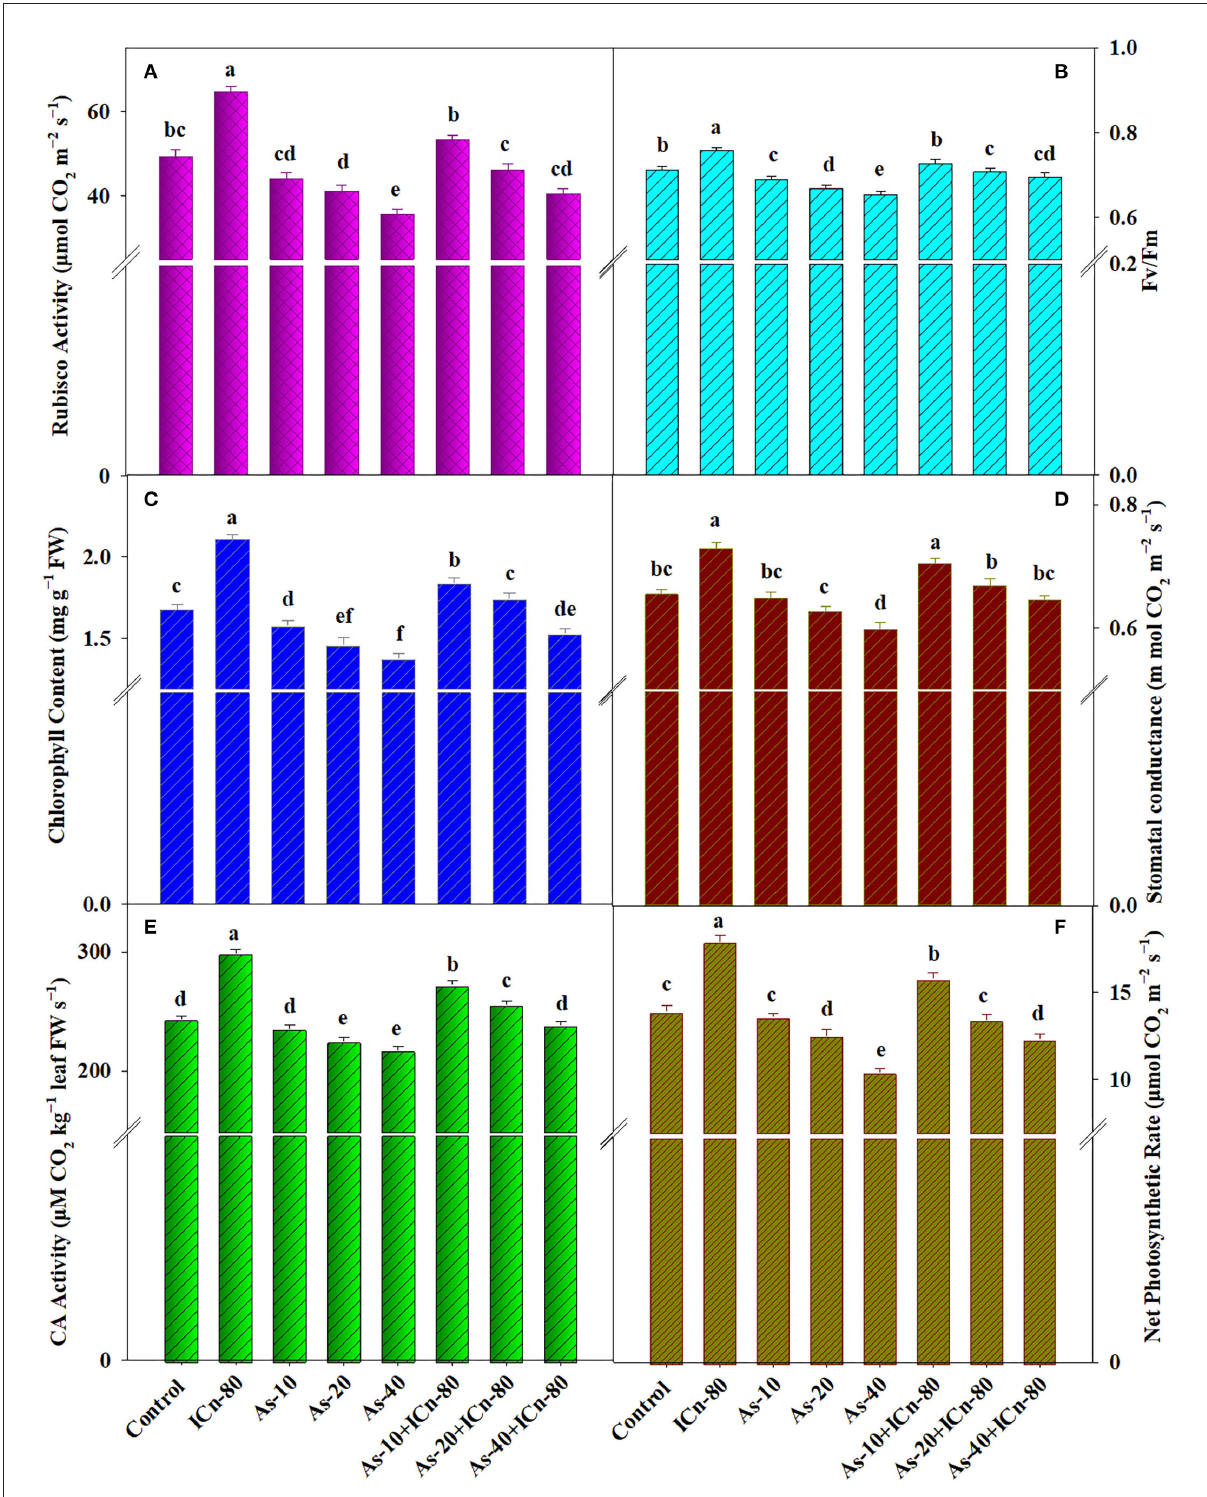
FIGURE1 RuBisCo activity (A) , chlorophyll fluorescence (Fv/Fm) (B) , chlorophyll content (C) , stomatal conductance (D) , carbonic anhydrase activity (E) , net photosynthetic rate (F) of peppermint ( Mentha piperita L.) at 150 days after transplanting. Plants were grown with/without As stress (10, 20, or 40mg kg − 1 of soil, as Na 2 HAsO 4 · 7H 2 O) and treated with ICn (80mg L − 1 ). Data are presented as treatment mean ± SE ( n = 5). Means within a column followed by the same letter are not significantly different ( P <